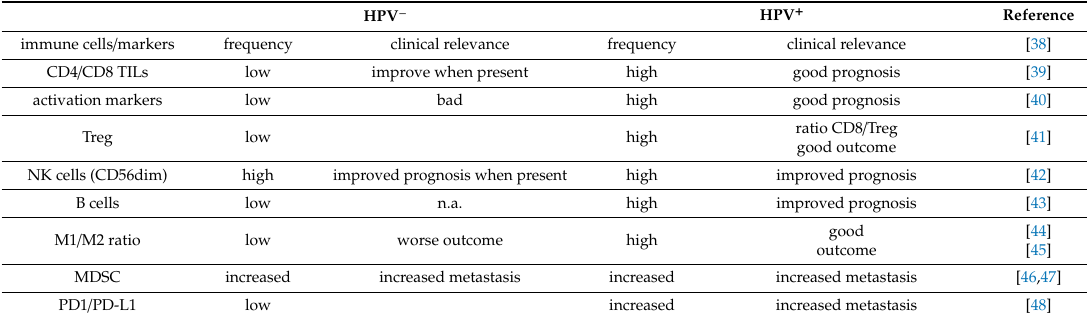
Table 3. Di ff erences in the composition of the TME and its clinical relevance in HPV + and HPV - HNSCC